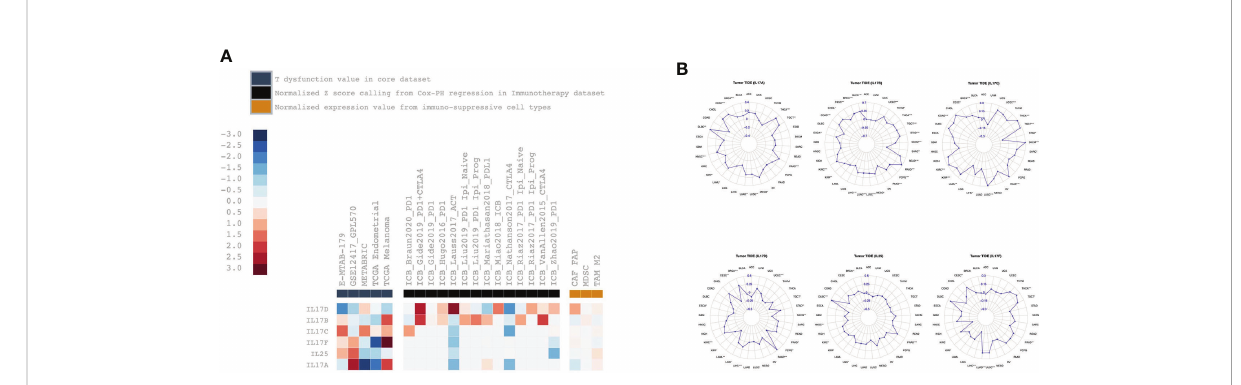
FIGURE 6 The correlation analysis between IL-17A – F family expression and Tumor Immune Dysfunction and Exclusion-related factors including (A) T dysfunction value, normalized z score calling from Cox-PH regression in immunotherapy, normalized expression value from immune- suppressive cell types, and (B) TIDE